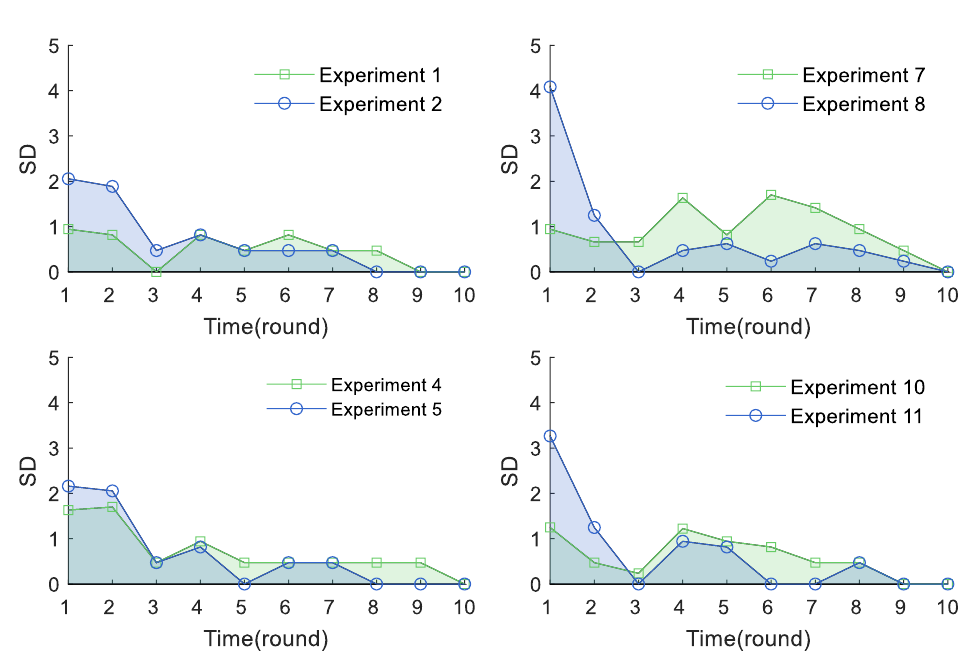
Figure 6. Effects of information feedback on free-riding behaviour.